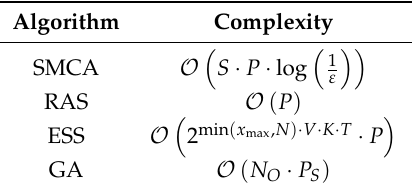
Table 3. The computational complexity of successive multi-step convex approximation (SMCA), the random access strategy (RAS), and the exhaustive searching scheme